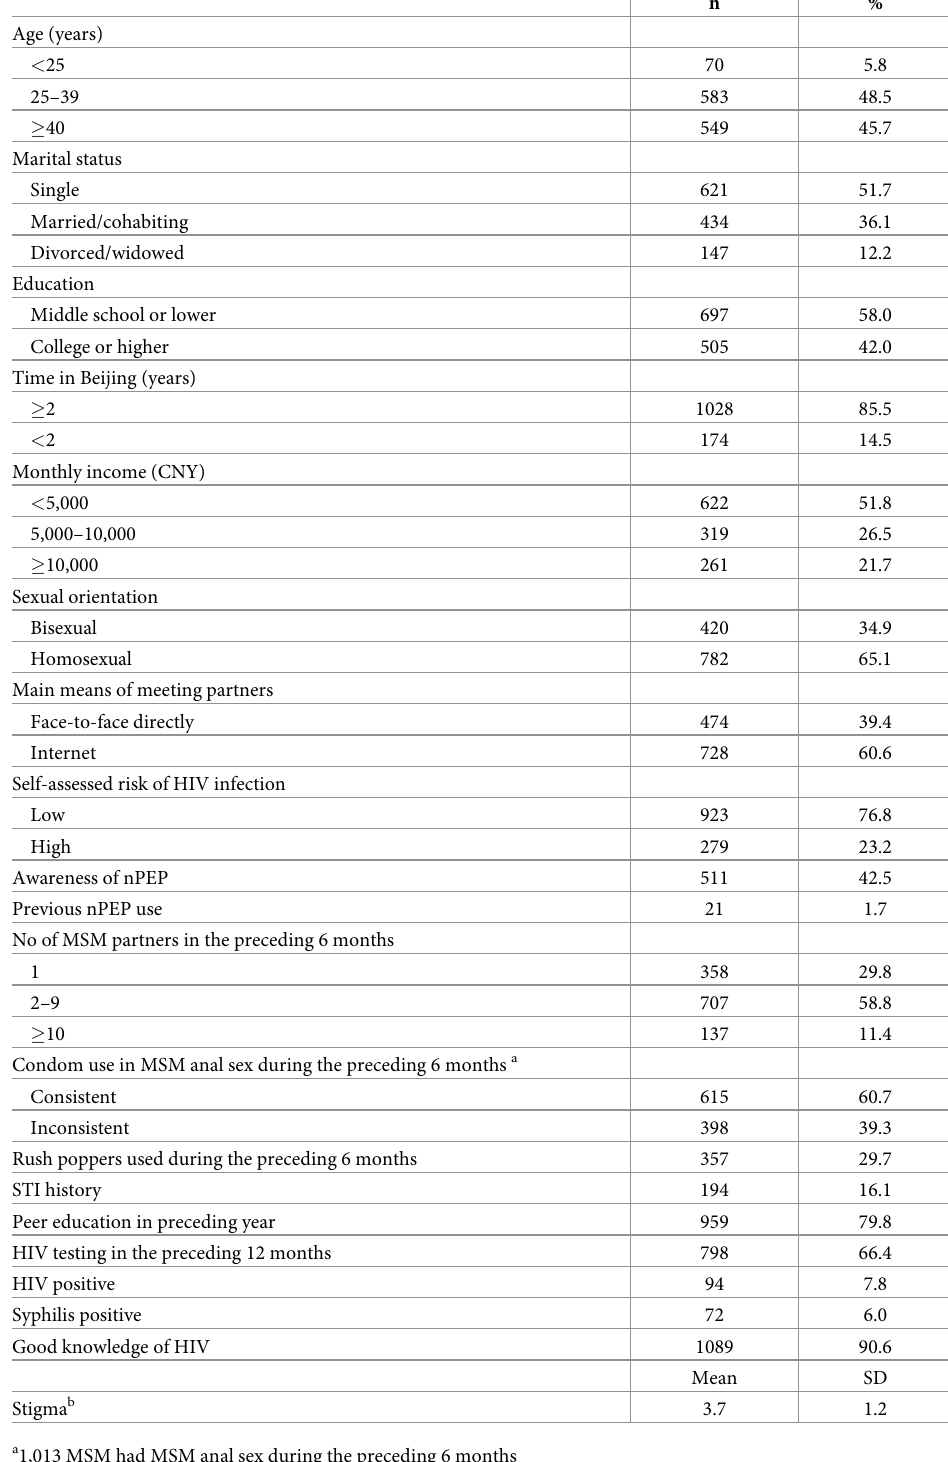
Table 2. Demographic and behavioral characteristics of MSM recruited in 2018 and 2019 in Beijing, China (N =